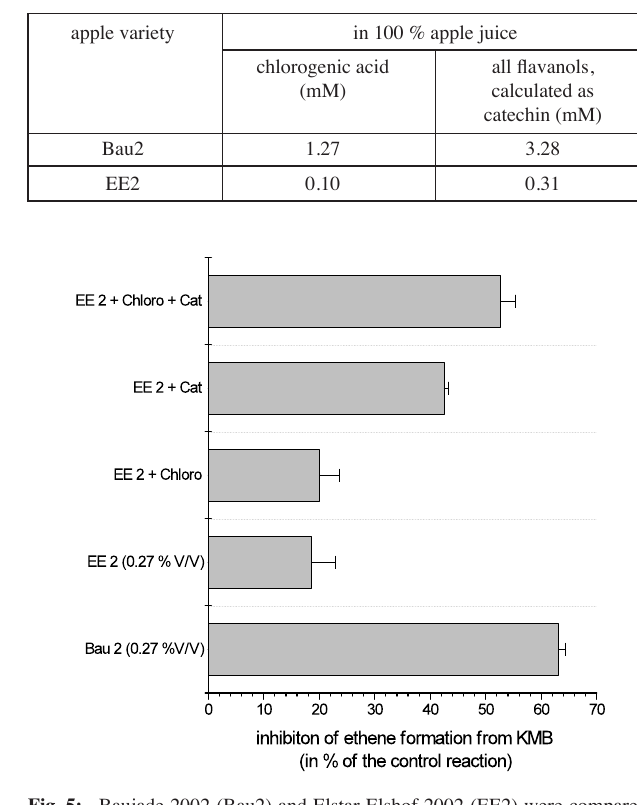
Fig. 5: Baujade 2002 (Bau2) and Elstar Elshof 2002 (EE2) were compared in the X/XOD/KMB test (apple juice: 0.27%V/V final concen tration) for their antioxidant activity. Whether their difference in antioxidant activity could be related to missing amounts of chlorogenic acid and catechins of EE2 (see Tab. 6) was checked by appropriate supple- mentation of EE2 with either chlorogenic acid or catechin or